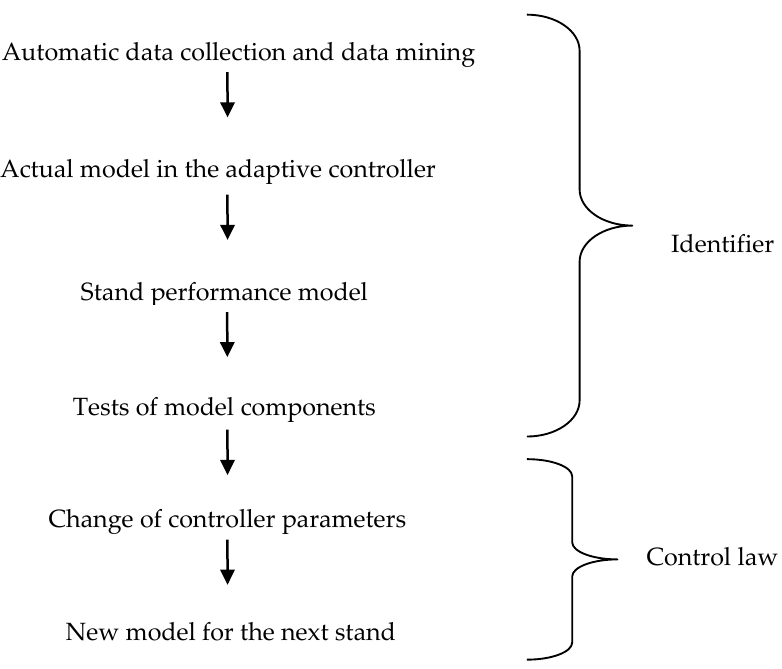
Figure 2. Elements of the adaptive control system.